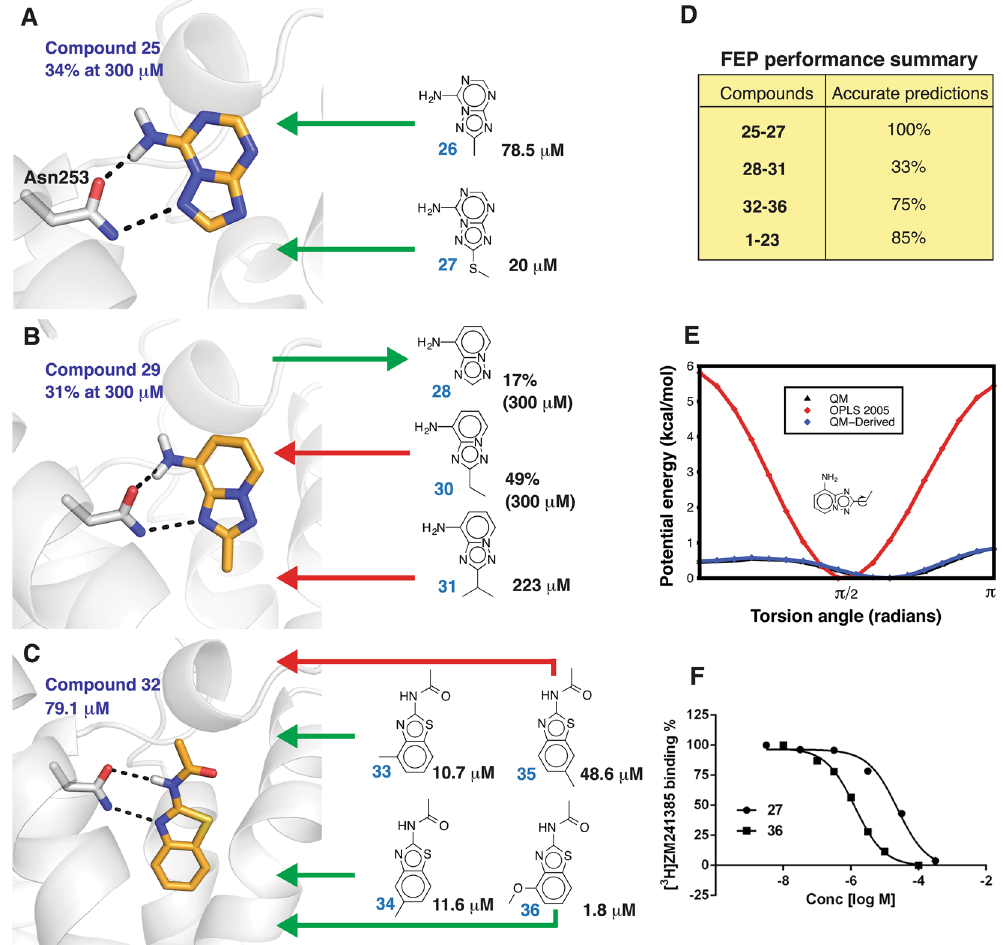
Figure 5. ( A – C ) Binding modes and summary of MD/FEP predictions for three nonpurine compound series. The orthosteric binding site of the A 2A AR is shown as a white cartoon with key residues in sticks. The predicted binding modes of the ligands are shown in sticks with carbon atoms in gold and hydrogen bonds indicated with black dashed lines. The experimental result for each fragment is shown as its K i ( μ M) or % displacement of radioligand binding at 300 μ M. The performed MD/FEP calculations are represented with arrows in red and green, which corresponds to accurate and erroneous predictions, respectively. ( D ) Summary of agreement of MD/FEP calculations with experimental data. The percentage of accurate predictions of the direction of the binding free energy change is shown. ( E ) Potential energy curve for the indicated torsion calculated from OPLSAA_2005, DFT (QM), and a molecular mechanics potential fitted to the DFT results (QM-Derived). ( F ) Concentration-effect curves for displacement of radiolabeled A 2A AR antagonist [ 3 H]ZM241385 by compounds 27 and 36